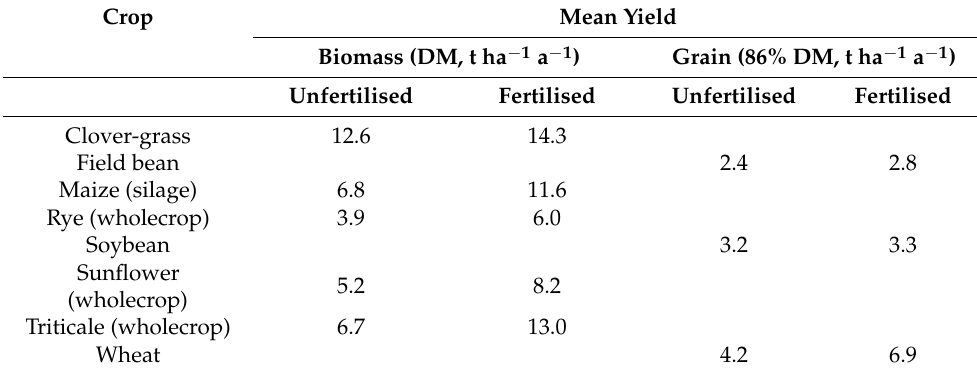
Table 3. Mean crop yields 2010–2017 (DM = dry matter).